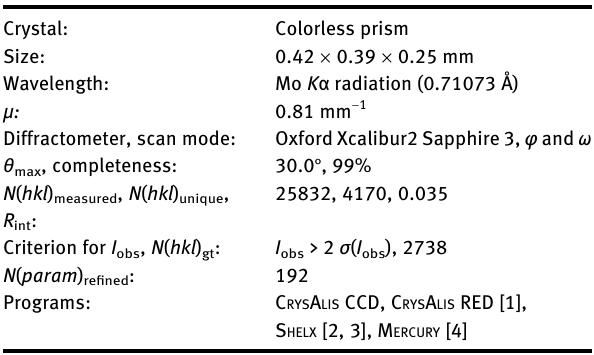
Table  : Data collection and